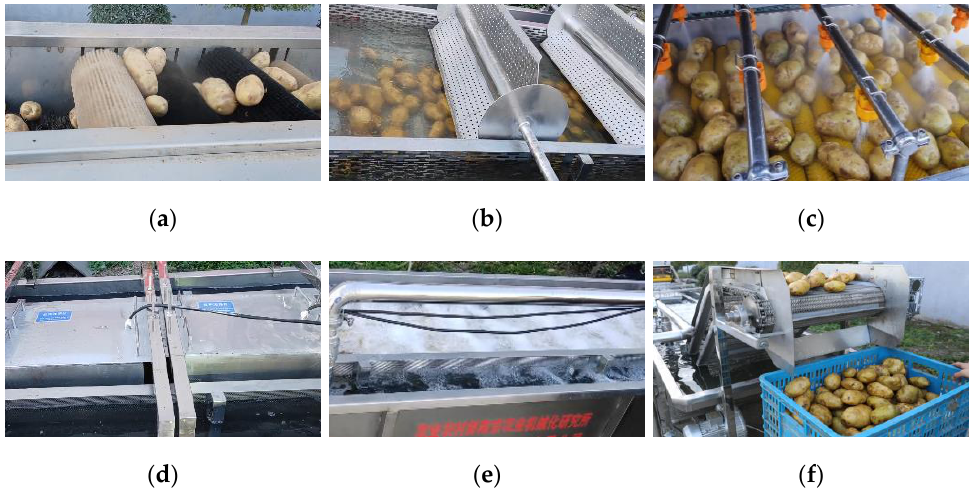
( c ) Figure 13. Ultrasonic sound intensity distribution. ( a ) Bottom surface of ultrasonic vibration plate; ( b ) 5cm from the bottom surface of ultrasonic vibration plate; ( c ) 10cm from the bottom surface of ultrasonic vibration plate. b. Selection of key parameters of bubble cleaning equipment The results show that when the bubble strength is 300 L/min, the residual impurities of potato tubers have been cleaned basically. For some impurities that have not been cleaned off, it is still unable to wash off them by continuously increasing the bubble strength. Therefore, the bubble strength is finally selected as 300 L/min. At the same time, since ultrasonic cleaning and bubble cleaning share a set of conveying net chains, in order to realize the effective connection and matching of the two parts, the cleaning time of the bubble eqipment is 40 s. At this time, the movement speed of the conveying net chain in the ultrasonic and bubble combination mechanism is 0.05 m/s. 3.3. Gradient Cleaning Test of Potato The gradient cleaning process of potatoes is shown in Figure 14. The potato tubers